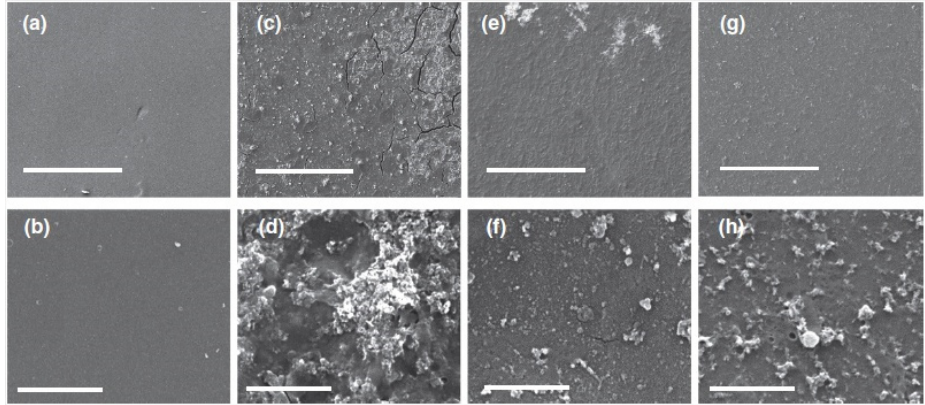
Figure 8. Electron micrograph of the original nanofilter ( a , b ); the water from the Foss reservoir from the MF only pretreatment ( c , d ) is contaminated; the water from the Foss reservoir from the EC-MF pretreatment ( e , f ) and the model solution ( g , h ) are contaminated. The 1000× magnified image and the scale bar in the top row represent 100 μ m. The bottom row and the 4 μ m scale bar show images at a higher magnification (18,000×).